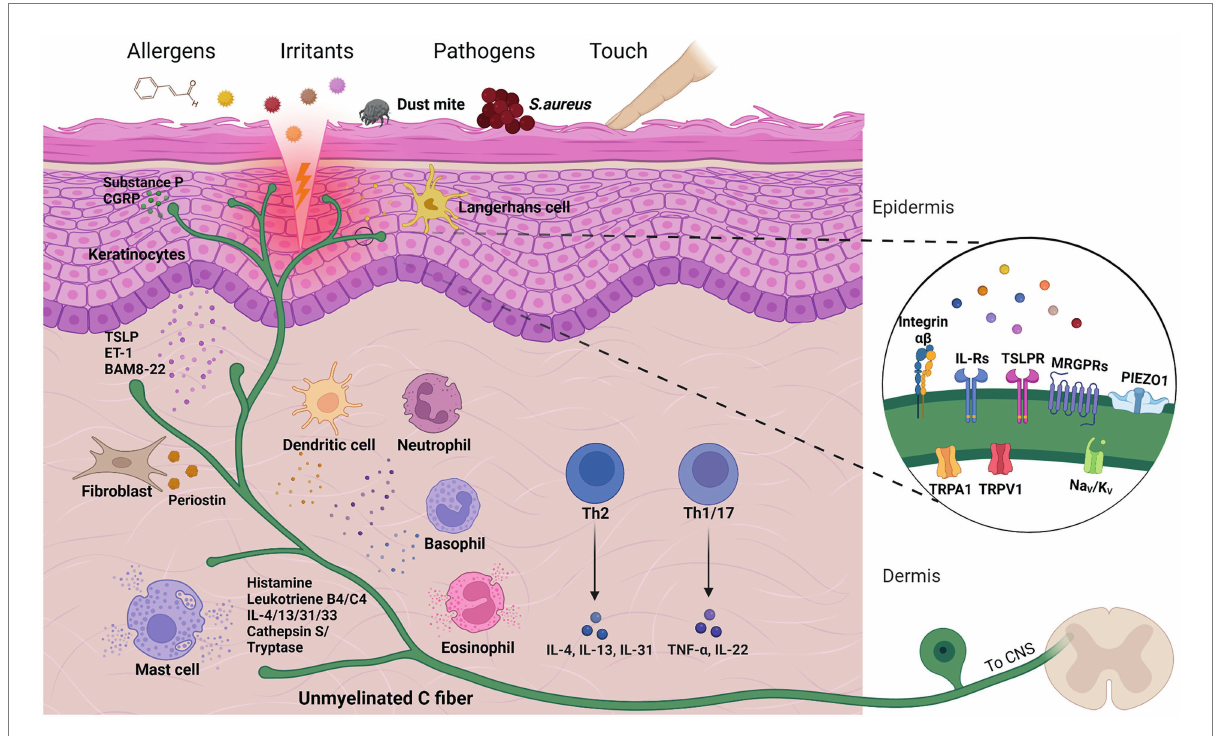
FIGURE 1 Cells and molecules in cutaneous itch transmission. Chemical or mechanical triggers can activate sensory neurons to produce the sensation of itch, a process characterized by intercellular crosstalk and both skin and immune cell activation. A selection of pruritogen receptors is depicted in close-up. Created with